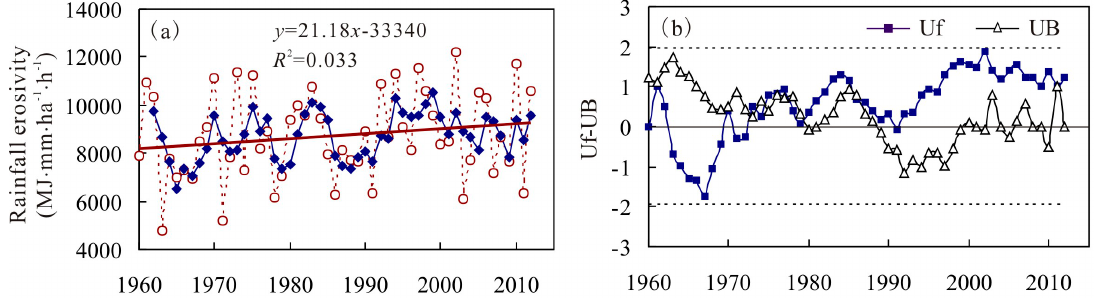
Figure 4. Variation of ( a ) annual rainfall erosivity and ( b ) the corresponding Mann-Kendall (M-K) test trends during the period of 1960–2012 (the line with the solid dots in ( a ) marks the three-year moving average and the horizontal dashed lines in ( b ) represent the critical value of the 0.05 significance level).